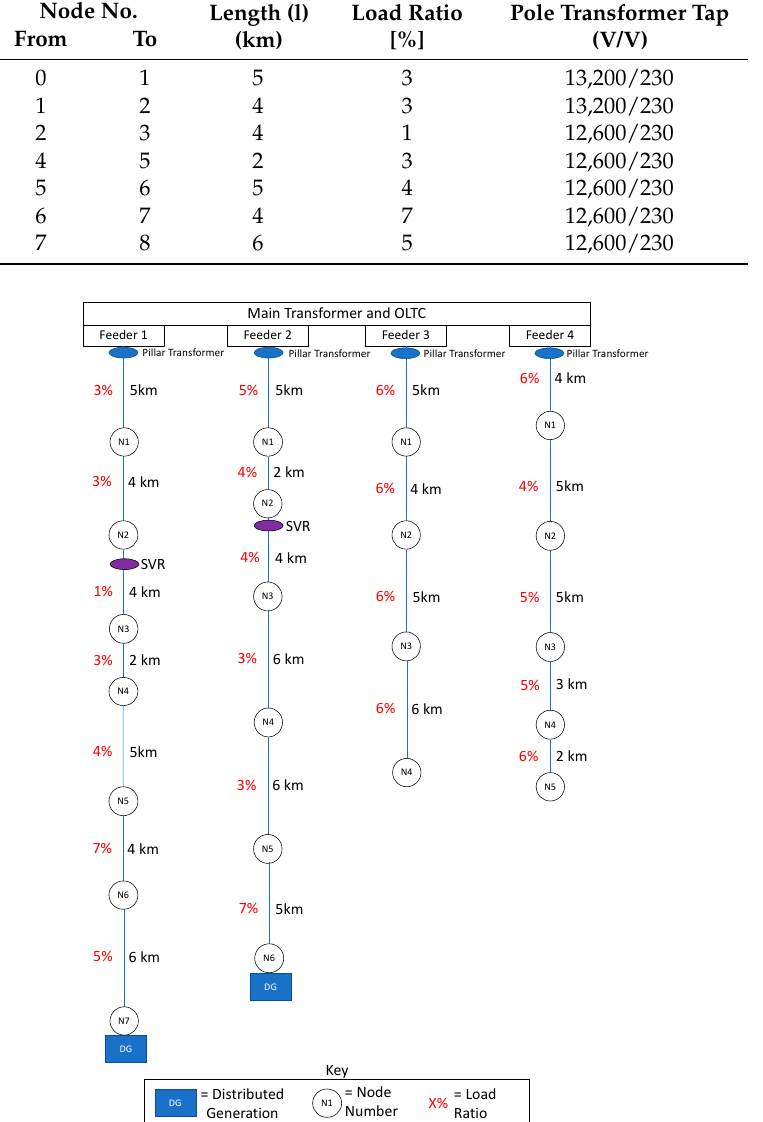
Figure 2. Hypothetical power distribution network scheme.